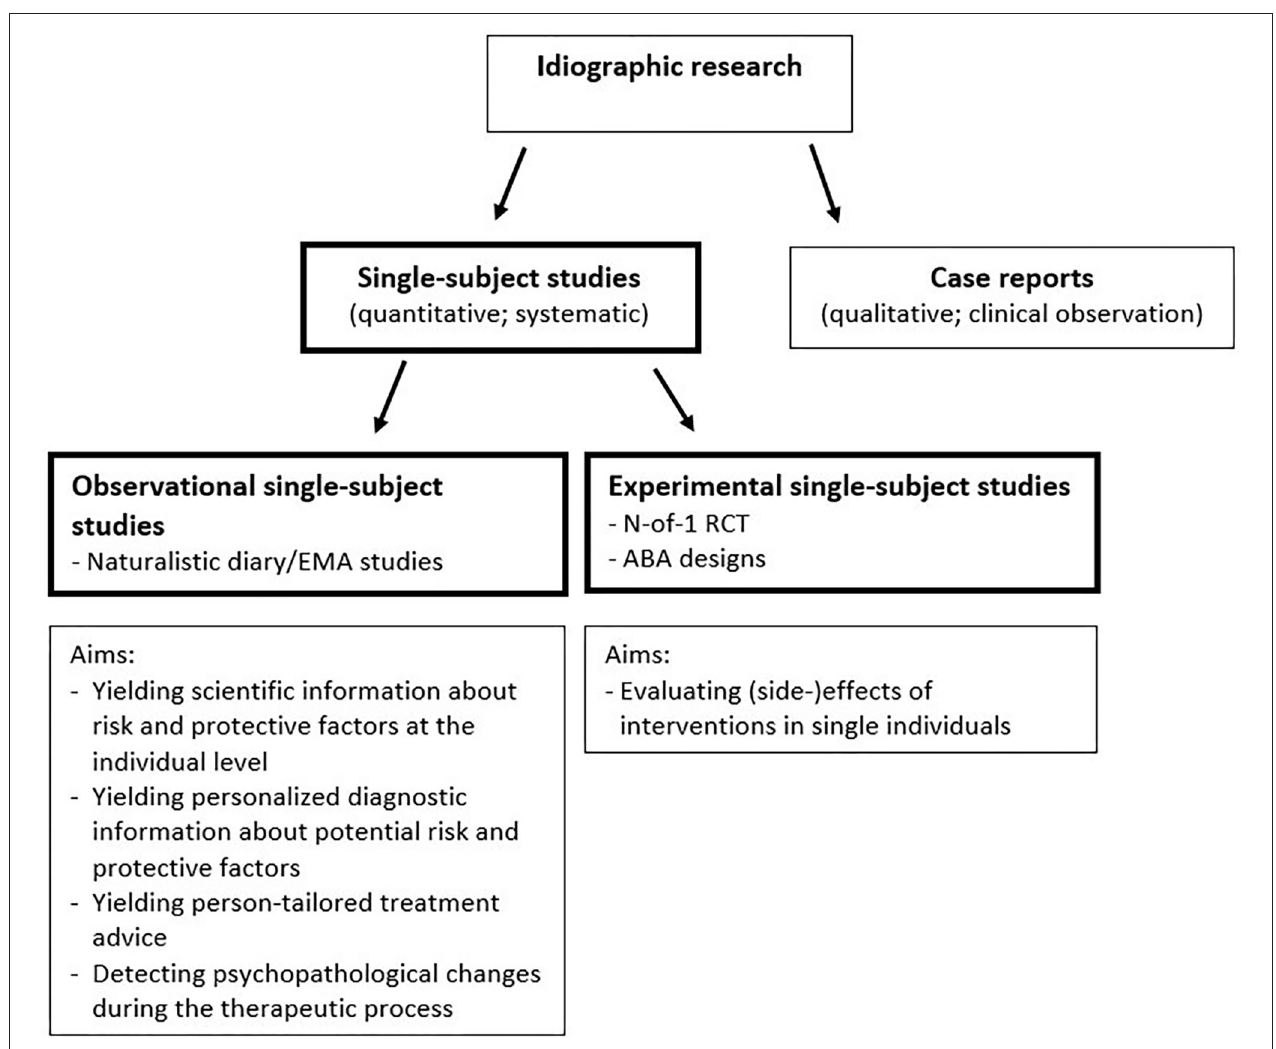
FIGURE 2 | Schematic illustration of different sorts of single-subject studies and some examples of aims of the two types of single-subject